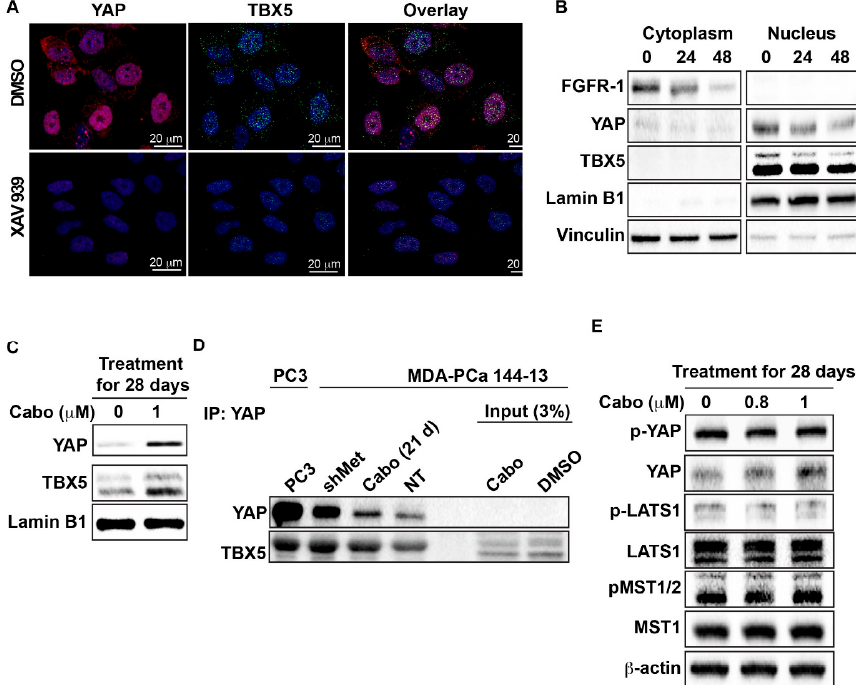
Figure 4. Nuclear localization of YAP and TBX5 and their complex formation. ( A ) Representative confocal microscopy images showing immunofluorescence of YAP (red, Alexa647), TBX5 (green, Alexa488), and DAPI (blue) in control and XAV939-treated PC3 cells; ( B ) sh-c-MET MDA PCa 144-13 cells were treated with XAV939 for 24 or 48 h. Nuclear and cytoplasmic fractionation was performed and lysates were immunoblotted for FGFR1, YAP, and TBX5 expression. ( C ) MDA PCa 144-13 cells were treated with or without cabozantinib. Nuclear extracts were prepared, and YAP and TBX5 expression were determined by immunoblotting; ( D ) Interaction between YAP and TBX5. Cell lysates from PC3 and MDA PCa 144-13 (NT-transfected, sh-met–transfected, cabozantinib-treated) were prepared and immunoprecipitated with YAP antibody or control IgG. Immunoblots of input lysates (3% of inputs) of DMSO and cabozantinib-treated MDA PCa 144-13 cells are also shown. ( E ) MDA PCa 144-13 cells were treated for 28 days with the indicated cabozantinib concentrations and the e ff ect on key components of the Hippo signaling pathway was examined. Immunoblot analysis of whole cell lysates was performed, and p-YAP (S127), YAP, pLATS1, LATS, pMST1 / 2, and MST1 expressions were determined. More details of western blot, please view at the supplementary